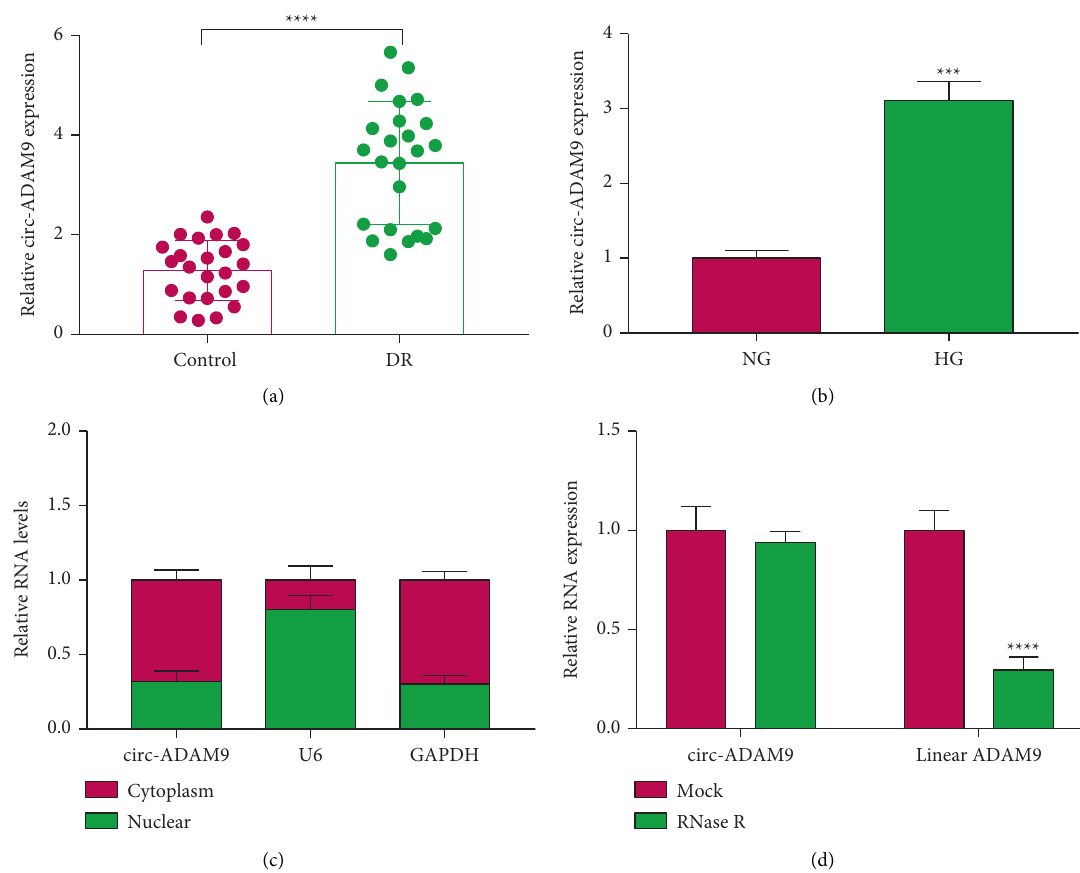
Figure 1: The expression of circ-ADAM9 in DR patients and HG-induced ARPE-19 cells. (a) The circ-ADAM9 expression in the serum of DR patients and normal control volunteers was detected by qRT-PCR. (b) QRT-PCR was used to measure circ-ADAM9 expression in ARPE-19 cells under HG and NG conditions. (c) Subcellular localization analysis was used to detect circ-ADAM9 expression in the cytoplasm and nuclear. (d) RNase R assay was performed to assess the circular characteristics of circ-ADAM9. ∗∗∗ P < 0 . 001 and ∗∗∗∗ P < 0 .